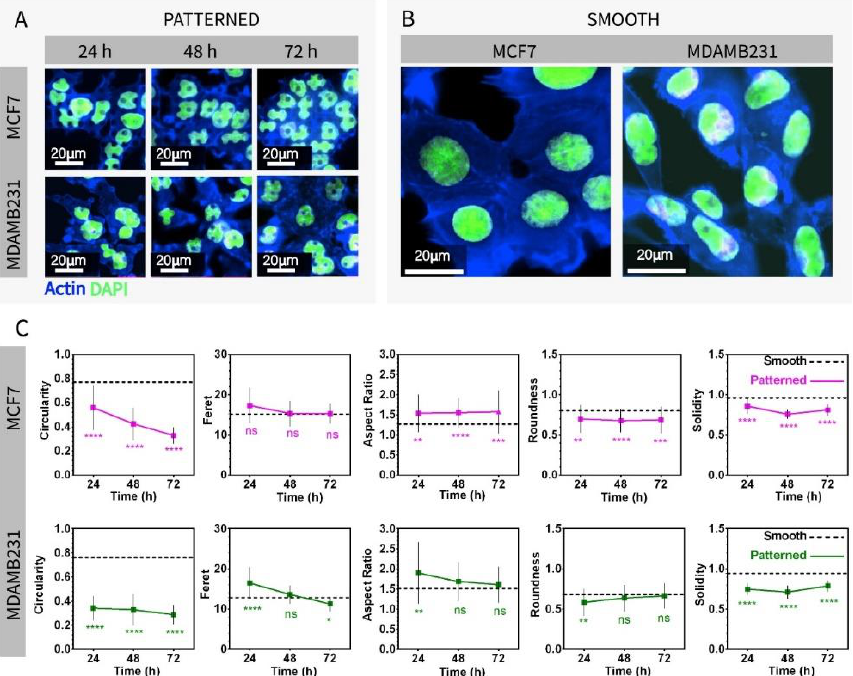
Figure 2. Micrographs of the MDAMB231 and MCF7 cell cytoskeleton and nuclei, and the nuclear deformations measured from these images. ( A ) Micrographs of the breast carcinoma cells on micropatterned chips imaged at 24, 48, and 72 h of cell culture (scale bars: 20 µ m, blue: Alexa Fluor Phalloidin for F-actin, green: DAPI for DNA). ( B ) Micrographs of the breast carcinoma cells on smooth chip imaged at 24 h of cell culture (scale bars: 20 µ m, blue: Alexa Fluor Phalloidin for F-actin, green: DAPI for DNA). ( C ) Nuclear shape analysis of MDAMB231 and MCF7 cells from the micrographs of micropatterned and smooth chips. Circularity, Feret, Aspect Ratio, Roundness, and Solidity parameters were used for the analysis (one-way ANOVA. MCF7: p circularity < 0.0001, p feret = 0.0252, p aspect ratio < 0.0001, p roundness < 0.0001, p solidity < 0.0001. MDAMB231: p circularity < 0.0001, p feret < 0.0001, p aspect ratio = 0.0155, p roundness = 0.0152, p solidity < 0.0001. * p < 0.005, ** p < 0.001, *** p < 0.0005, **** p < 0.0001).